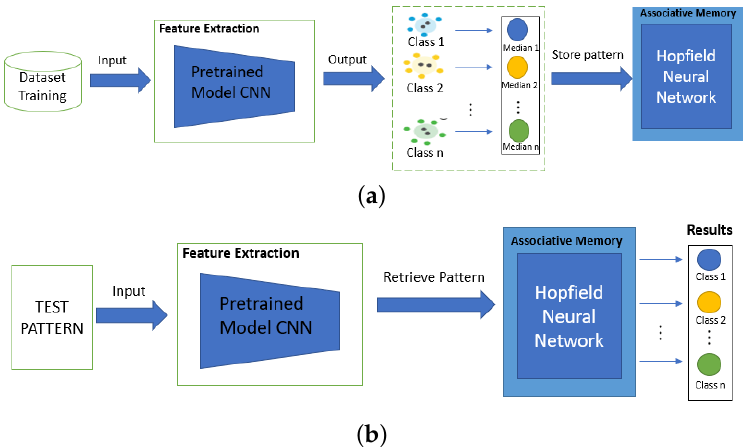
Figure 2. Overview of our hybrid CNN–RNN architecture. ( a ) training process; ( b ) inference